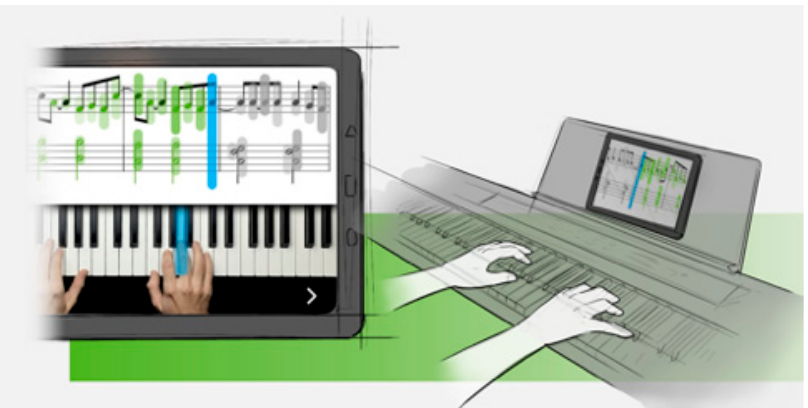
Figure 3. Performance analysis scenario.